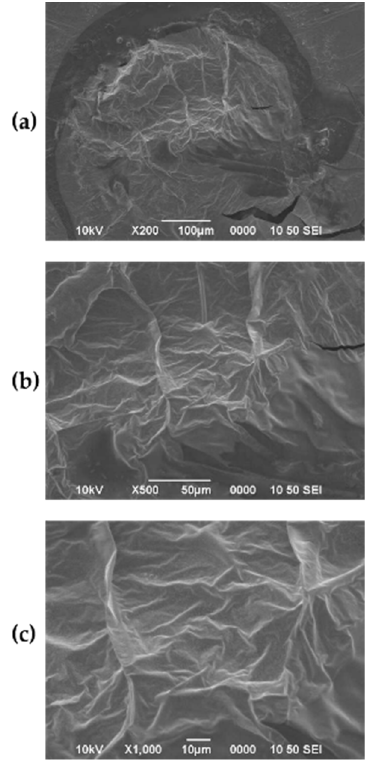
Figure 5. SEM image of the biofilm produced by cultivation of C. maltosa SM4 at 200 rpm and 1 L min − 1 at ( a ) 200×, ( b ) 500×, and ( c )